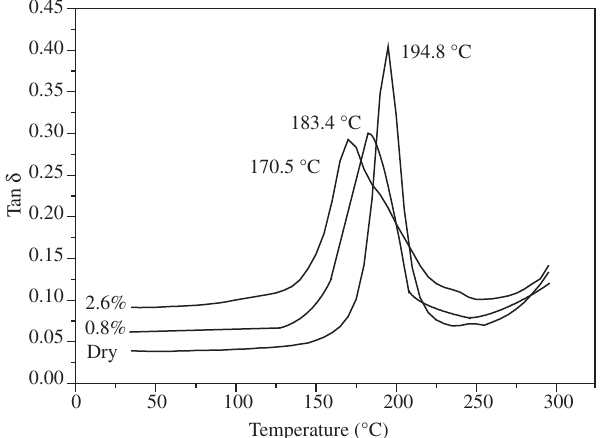
Figure 1. Tan delta ( δ ) as function of temperature of dry and wet carbon/ epoxy laminates.